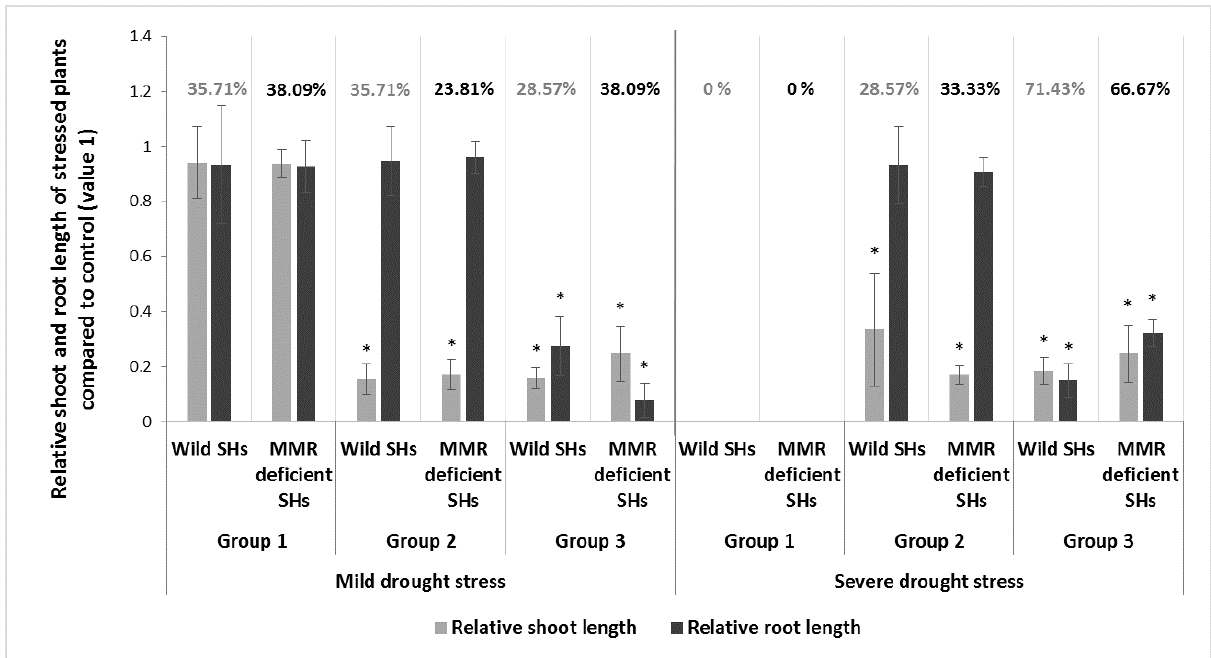
Figure 2. Classification of wild type somatic hybrids and their progenies (indicated as wild SHs), and MMR-deficient SHs (indicated as MMR-deficient SHs) by morphological adaptation to moderate and severe drought stress. Root and shoot lengths of stressed plants were compared to the same properties of control plants (value 1). * indicates significant differences ( p < 0.005) compared to control. The percentage values show the percentage of hybrids of different origins present in a given category (total number of wild SHs was 14, while MMR-deficient SHs was 21).